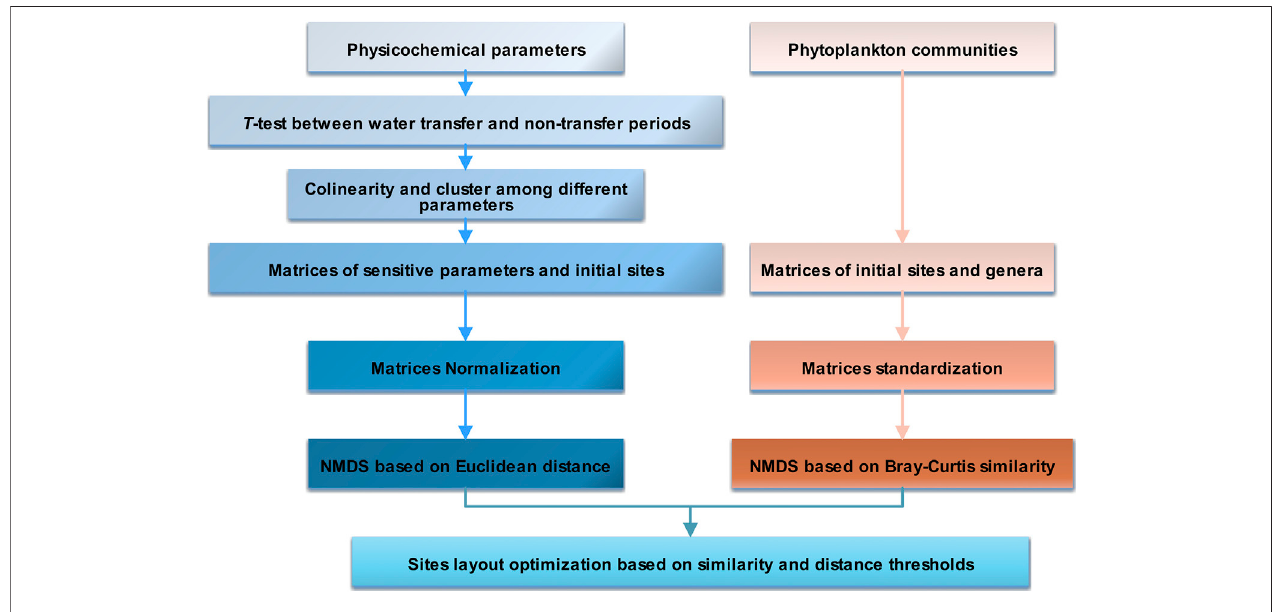
FIGURE 2 | The fl ow chart of sites optimization methodologies used in this